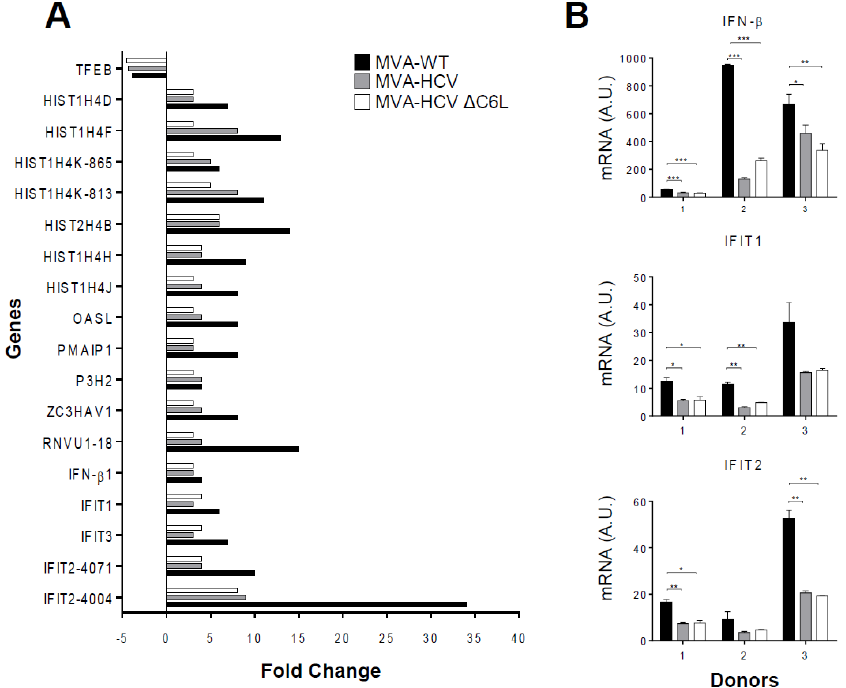
Figure 3. Microarray analysis of HCV antigen-regulated host genes in human moDCs infected with MVA-HCV and MVA-HCV ∆ C6L. ( A ) Clustering classification of host genes differentially regulated in MVA-WT-, MVA-HCV-, and MVA- HCV ΔC6L -infected human moDCs versus mock infected cells (FDR Prod p value < 0.05, fold change ≥2 or ≤−2 ). MoDCs were infected for 6 h and the expression